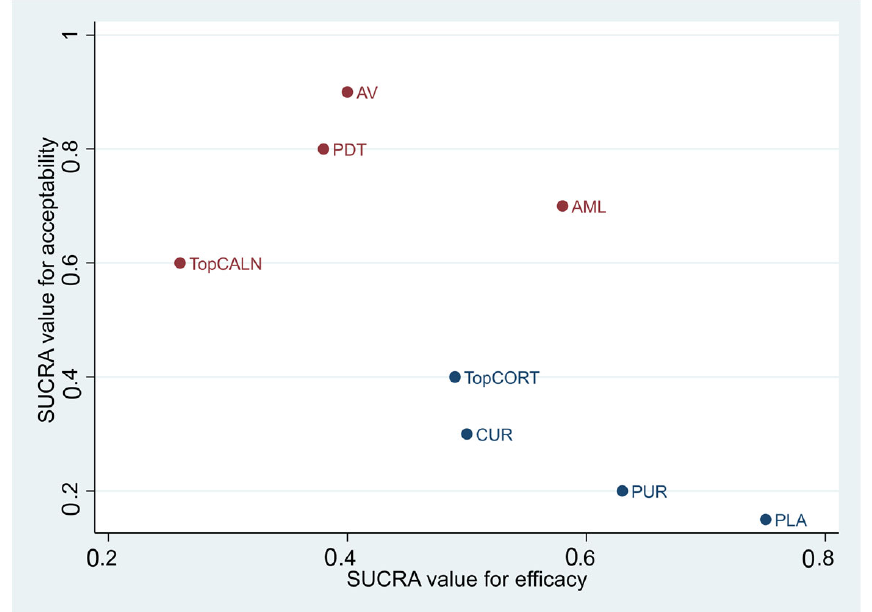
Figure 7. SUCRA Value for Safety and Efficacy of Interventions Used for Treatment of Oral Lichen Planus. Abbreviations: AV, aloe vera; PDT, photodynamic therapy; PUR, purslane; TopCALN, topical calcineurin; TopCORT, topical corticosteroid.